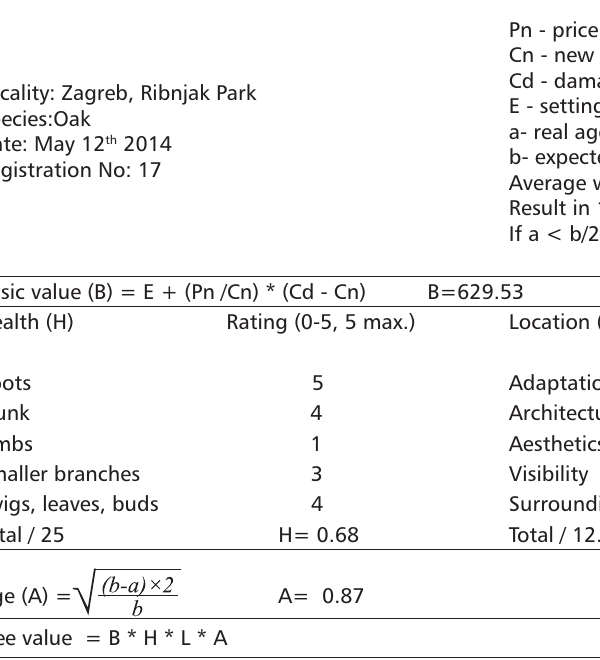
TABLE 1. Example of determining the price of trees using the Danish formula [17] VAT 03 – Tree evaluation – Danish model developed in 2003